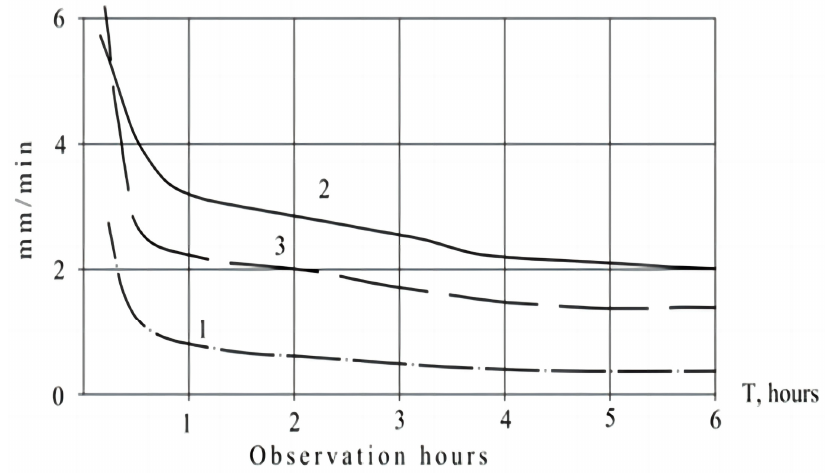
Figure 5. Water permeability of dark chestnut carbonate soil depending on soil cultivation: 1—disking; 2—loosening deep; 3—plowing normal [8].